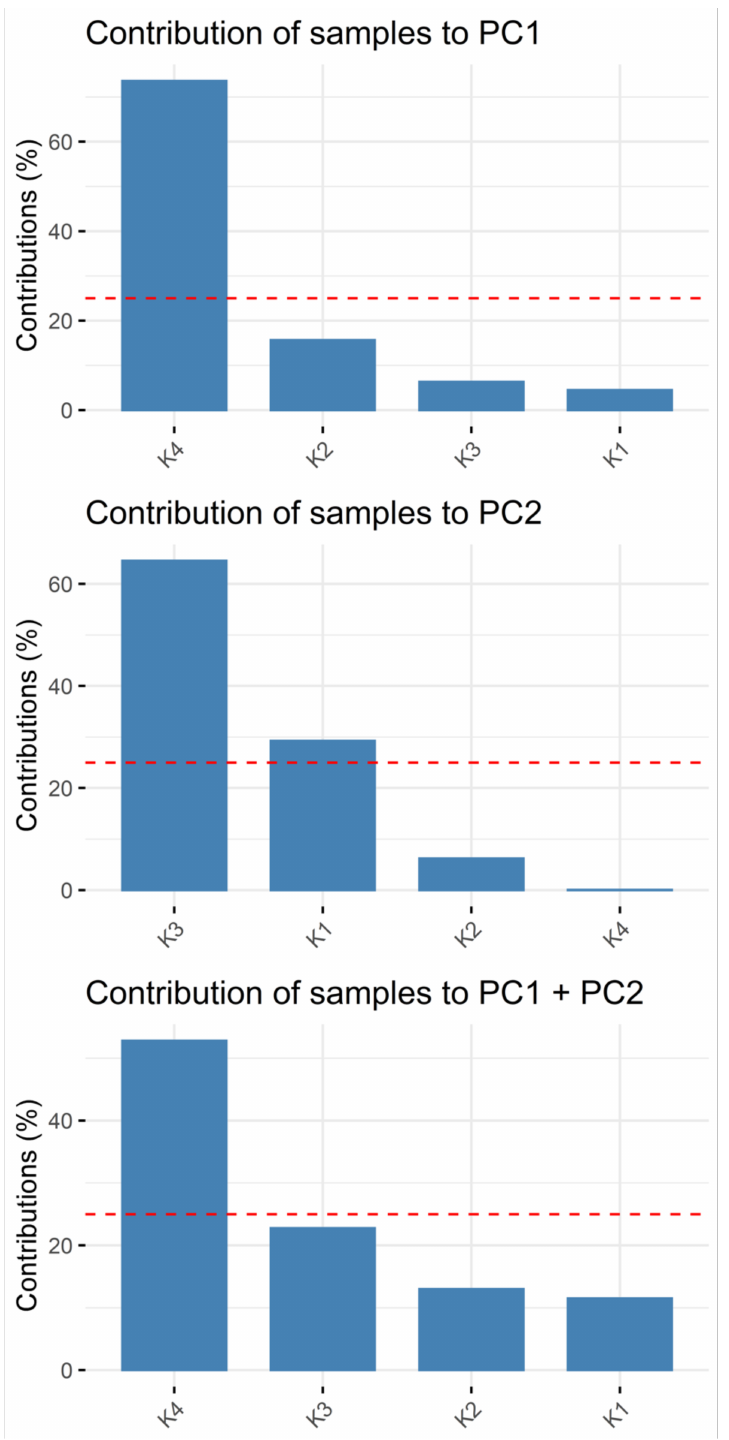
Figure 4. Contribution of samples to PC1 and PC2, red dashed line indicating average